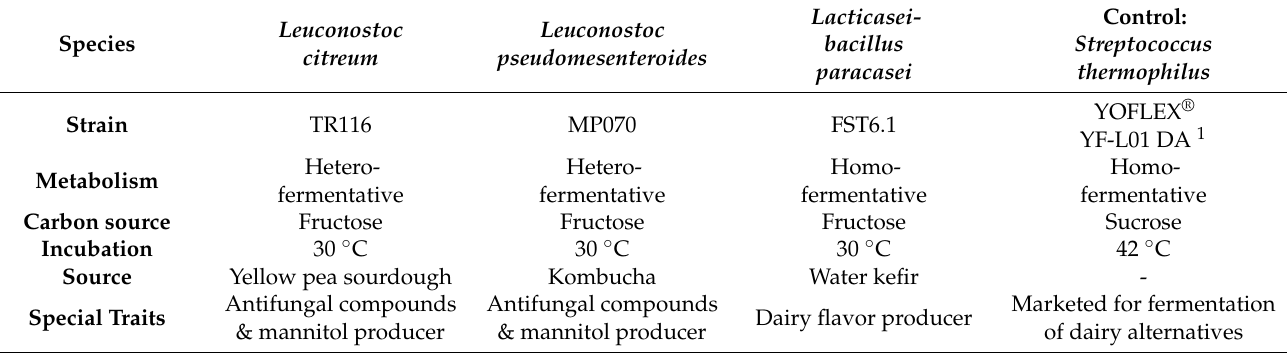
Table 2. Strains of lactic acid bacteria used in this study with relevant